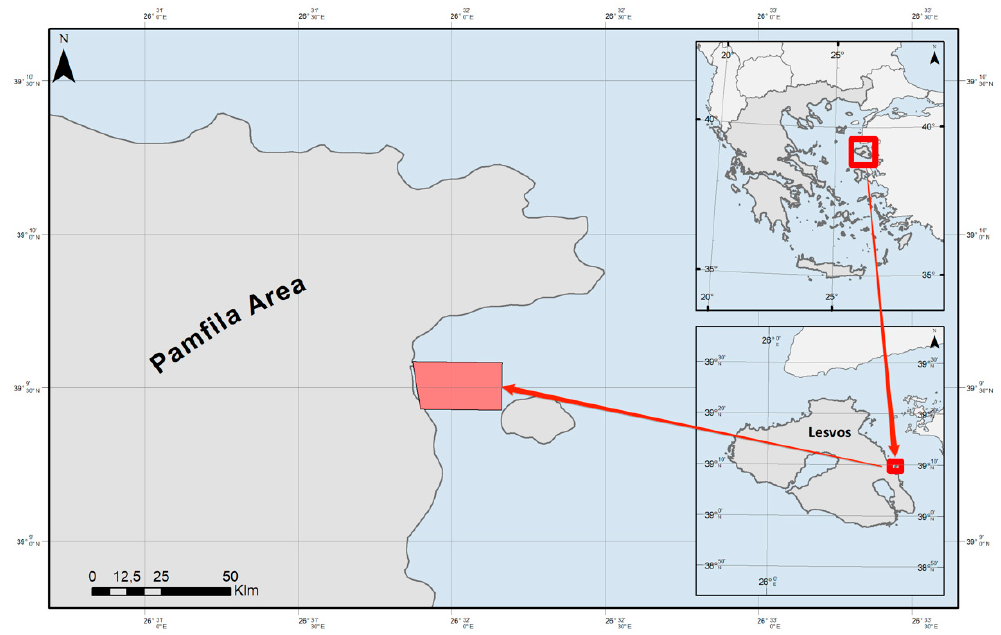
Figure 1. Location map of the Pamfila study area depicted with the red rectangle. Location maps of Greece (top right) and Lesvos Island (bottom right).